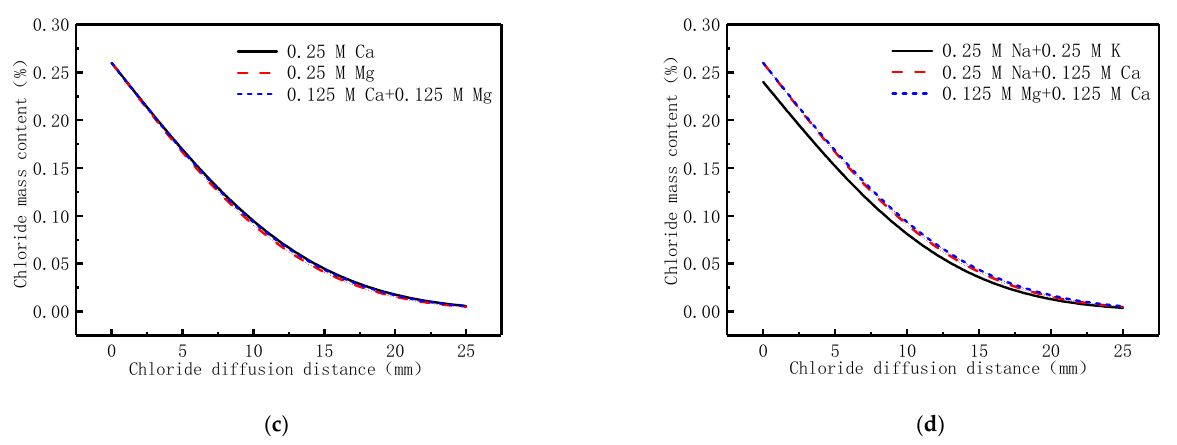
Figure 6. Simulation results of the diffusion behavior of chloride in different diffusion solutions under 0.5 MPa hydrostatic pressure. ( a ) Monovalent cationic diffusion source solutions; ( b ) Monovalent and Divalent cationic diffusion source solutions; ( c ) Divalent cationic diffusion source solutions; ( d ) Combined cationic diffusion source solutions. Table 6. Ionic radii of different types of